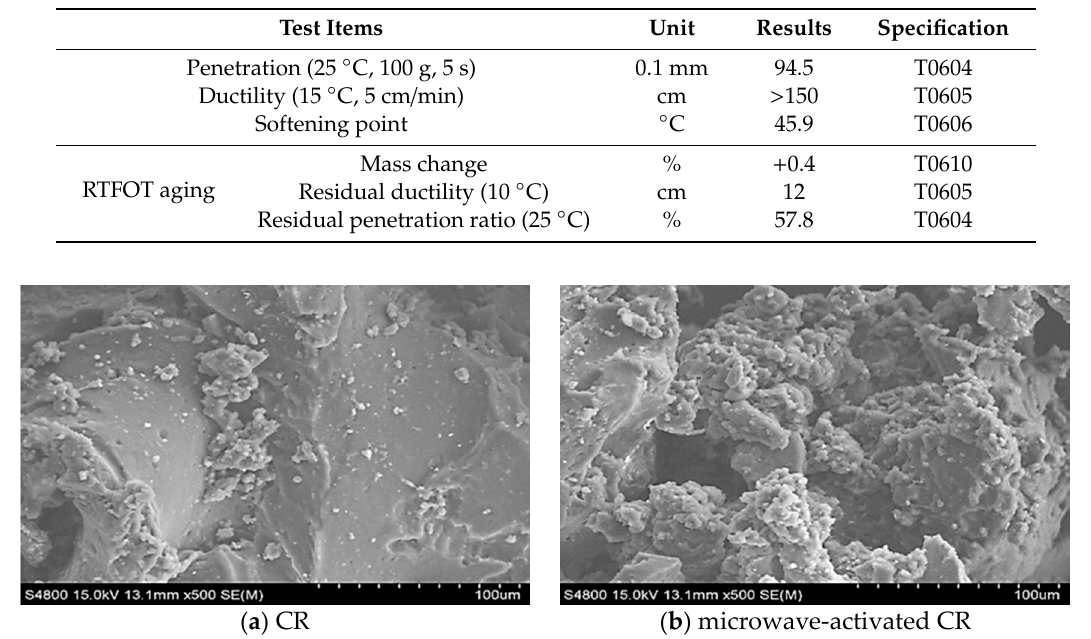
Figure 2. SEM image of crumb rubber (CR) particles and microwave-activated CR particles. Table 1. Physical properties of SK-90# bitumen.